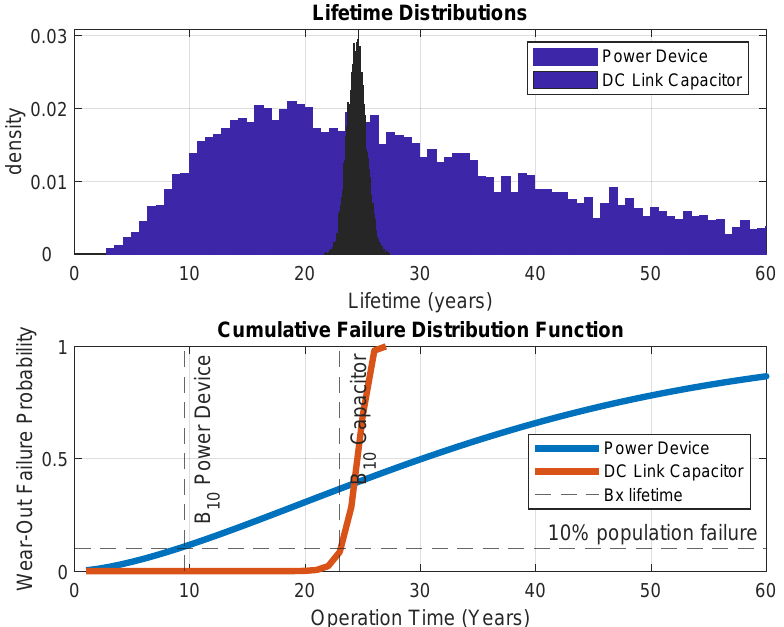
Figure 10. Results from the Monte Carlo showing the lifetime distributions and cumulative failure distributions of a single IGBT operating in the machine-side converter in the wind-based generation unit and a single dc-link capacitor also operating in the wind-based generation